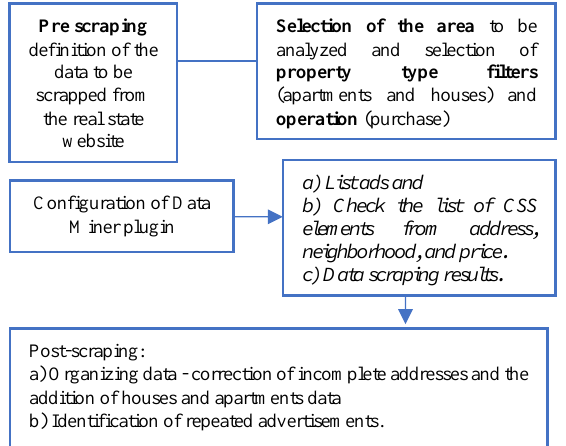
Figure 3. Web scraping procedure and